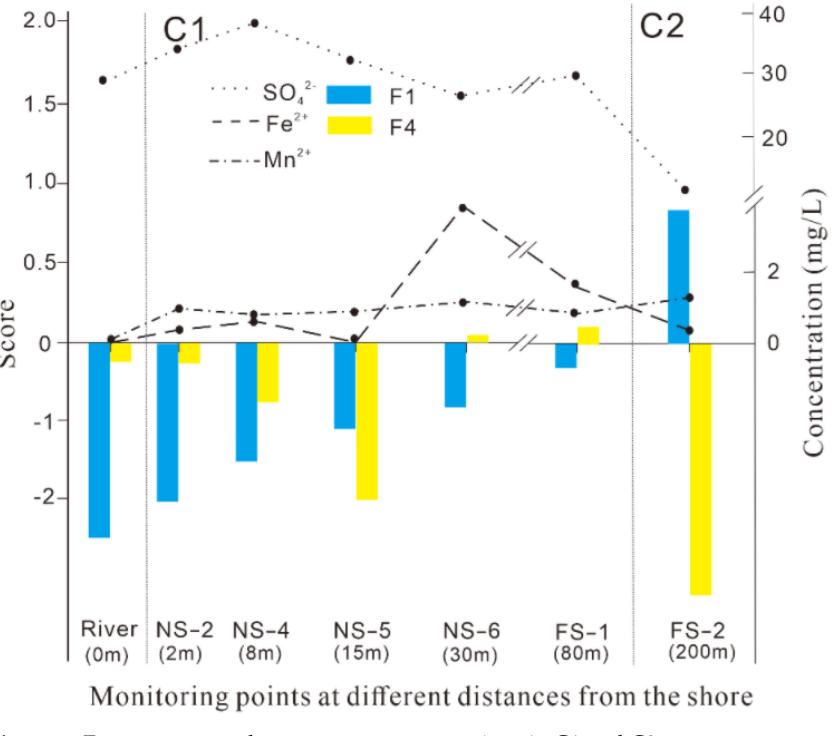
Figure 8. Factor scores and component concentrations in C1 and C2.